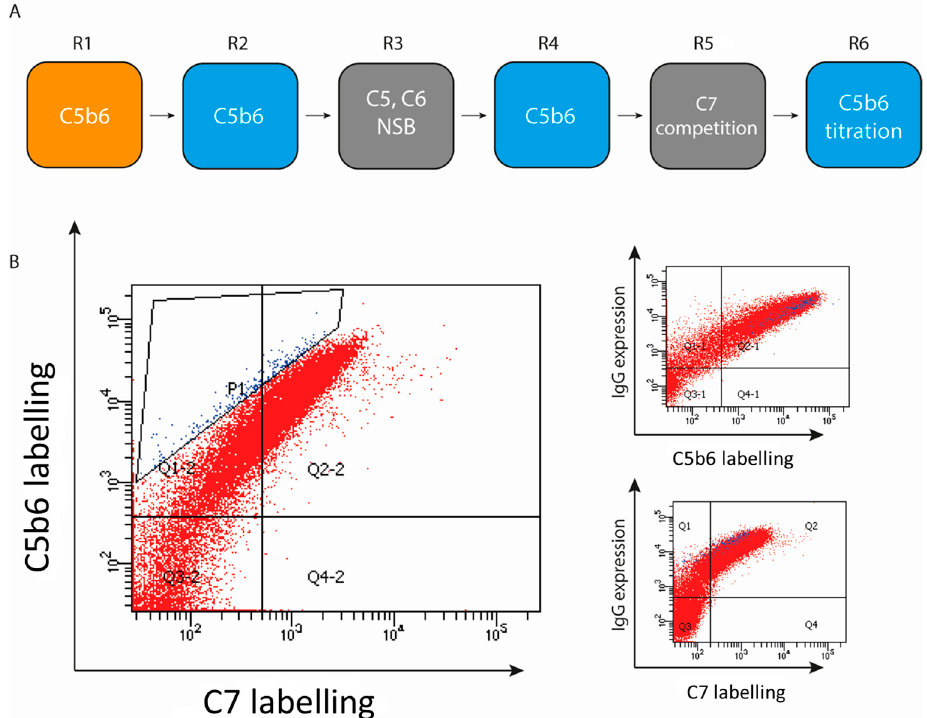
Figure 2. Naïve selections strategy and sorting. ( A ) Flow diagram of the 6 rounds of selection to isolate anti-C5b6 antibodies from a yeast library. Selection rounds are colour coded as MACS (orange), FACS (blue) and negative selection FACS (grey). NSB refers to a proprietary reagent to select against antibodies displaying nonspecific binding. ( B ) FACS plots of round 5, where clones were selected that show strong binding to C5b6, but no binding to C7 once bound to C5b6 already. These are coloured in blue. All three plots show the same population, with different parameters plotted on each